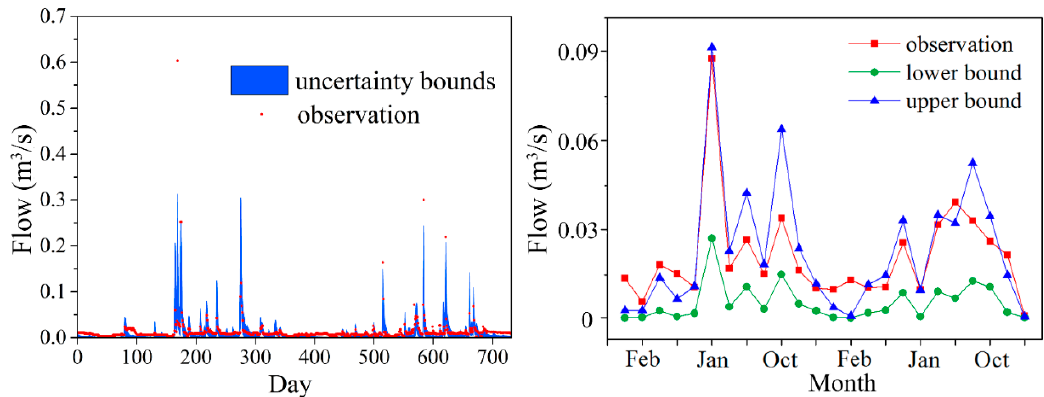
Figure 10. Observations and 95 PPU bounds of streamflow in the continuous modeling. The left and right parts present results of daily and monthly simulation, respectively.